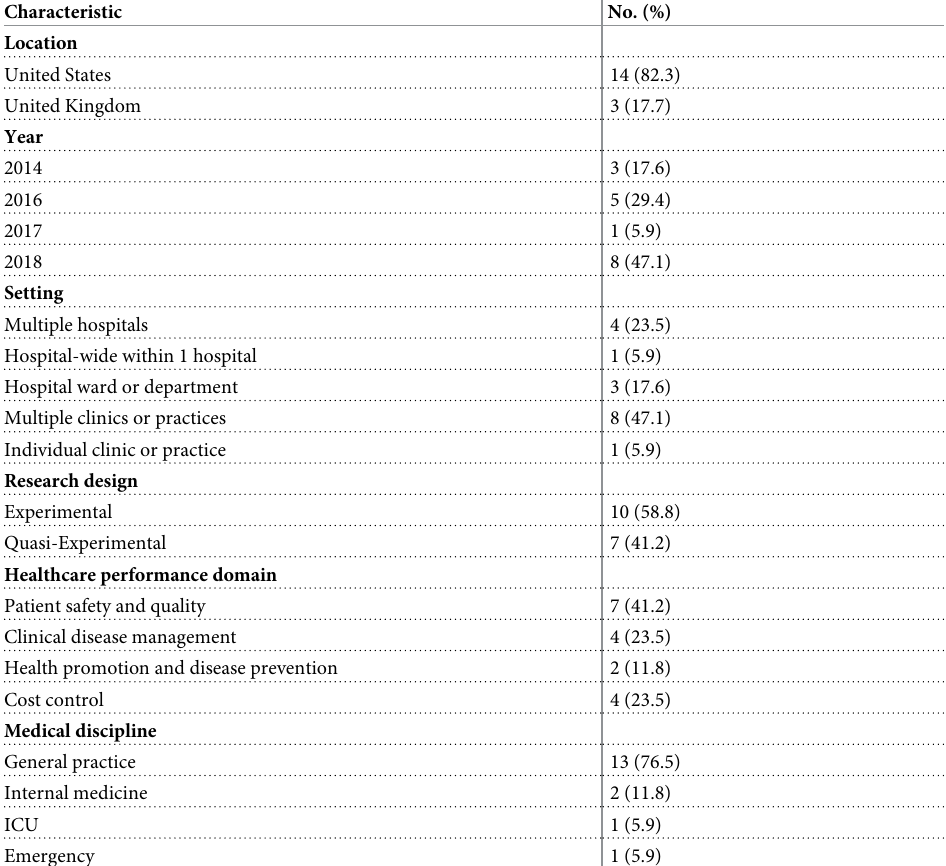
Table 3. Descriptive statistics of included papers investigating the effectiveness of behavioral economics informed interventions on physician behavioral change (n = 17).